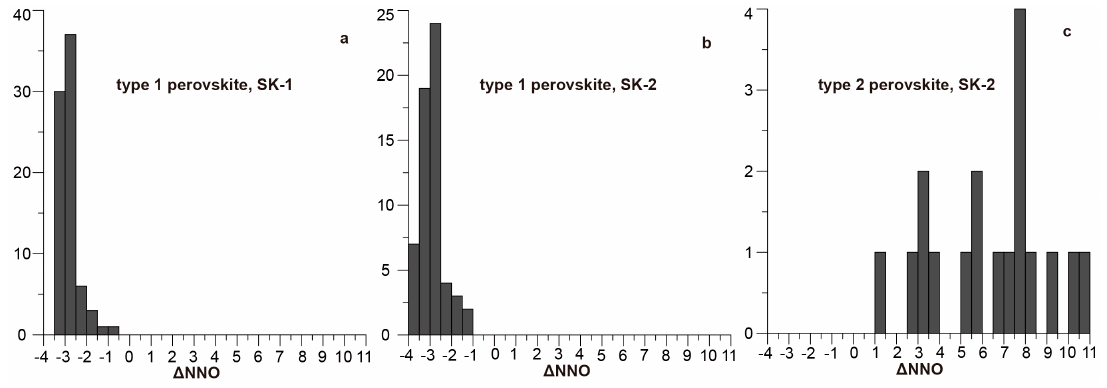
Figure 5. Frequency histograms of log fO 2 expressed relative to the NNO buffer ( Δ NNO) calculated using the perovskite oxybarometer developed by Bellis and Canil [4]. ( a ) type 1 perovskite from SK-1; ( b ) type 1 perovskite from SK-2; ( c ) type 2 perovskite from SK-2.